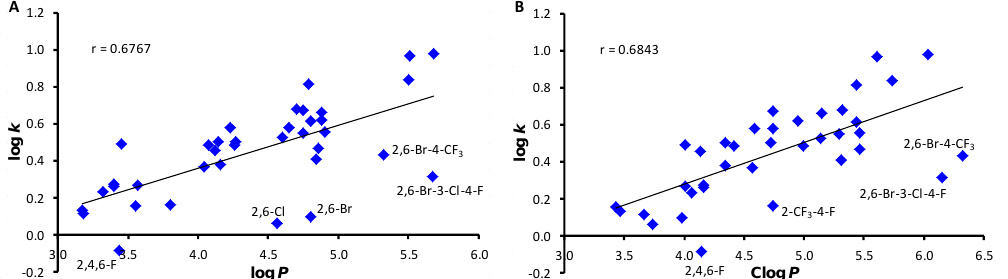
at least one ortho position) significantly decreases lipophilicity, while substitution of meta